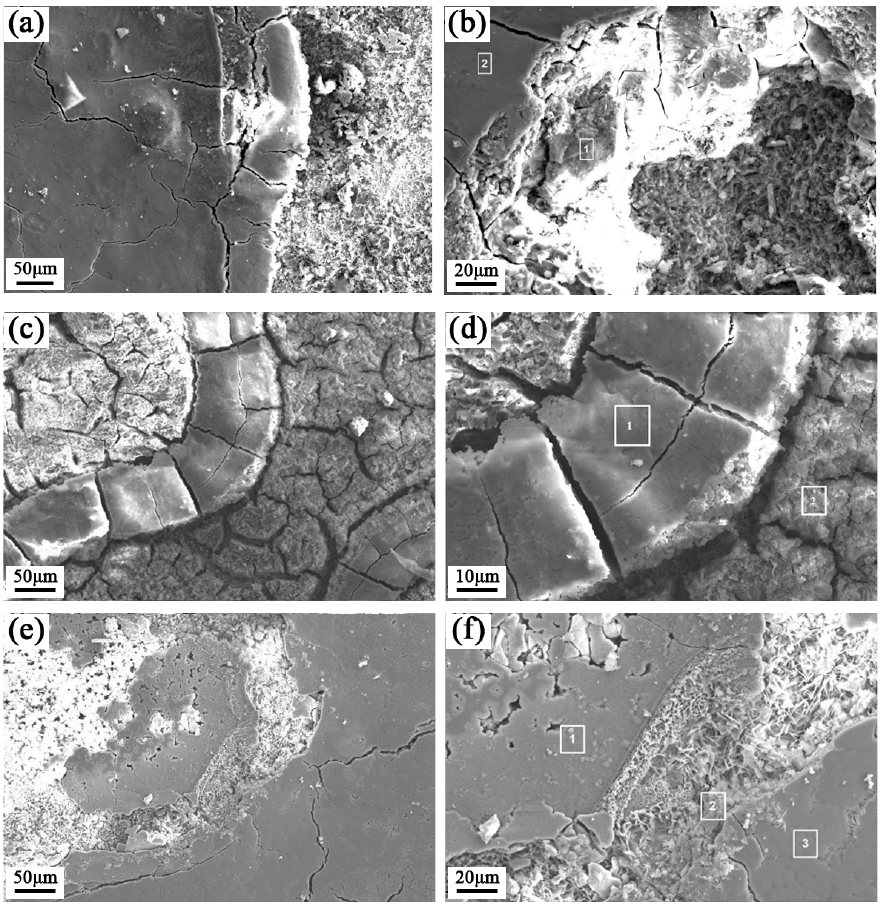
Figure 6. The microscopic morphology of the corrosion film after the 168 h flow loop tests at 20 ◦ C ( a , b ), 50 ◦ C ( c , d ), and 60 ◦ C ( e , f ).